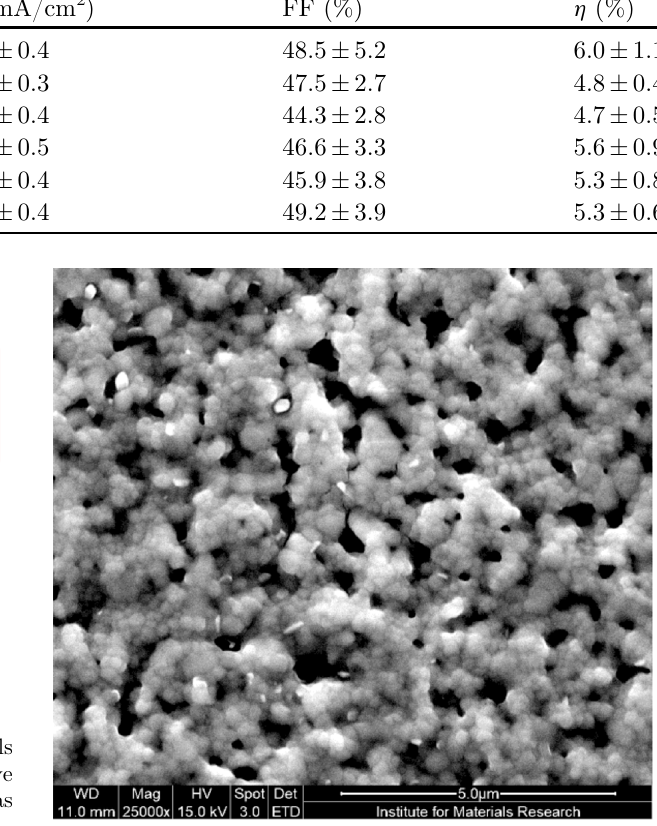
Fig. 6. Perovskite layer morphology after ultrasonic spray coating and vacuum